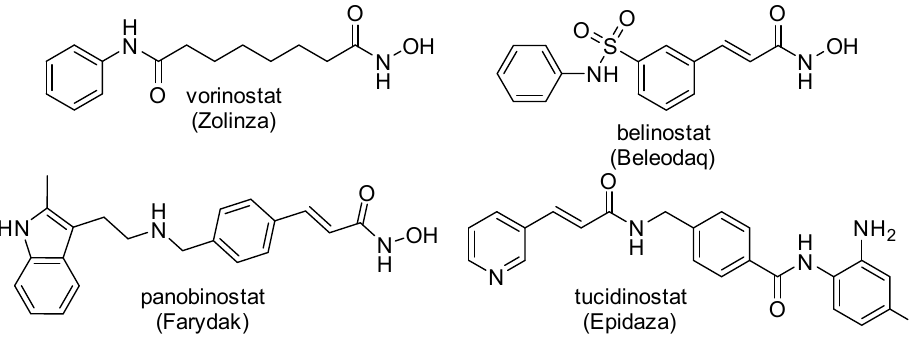
Figure 2. Chemical structure of licensed HDAC inhibitors. Resveratrol (RVT) (trans-3,5,4 ′ -trihydroxystilbene) (Figure 3) is a natural product